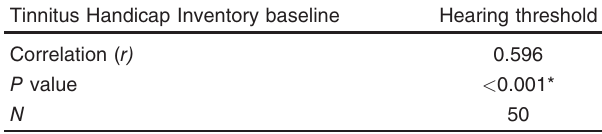
Table 4 Correlation between average of hearing thresholds (500, 1, 2, and 4kHz) level and Tinnitus Handicap Inventory